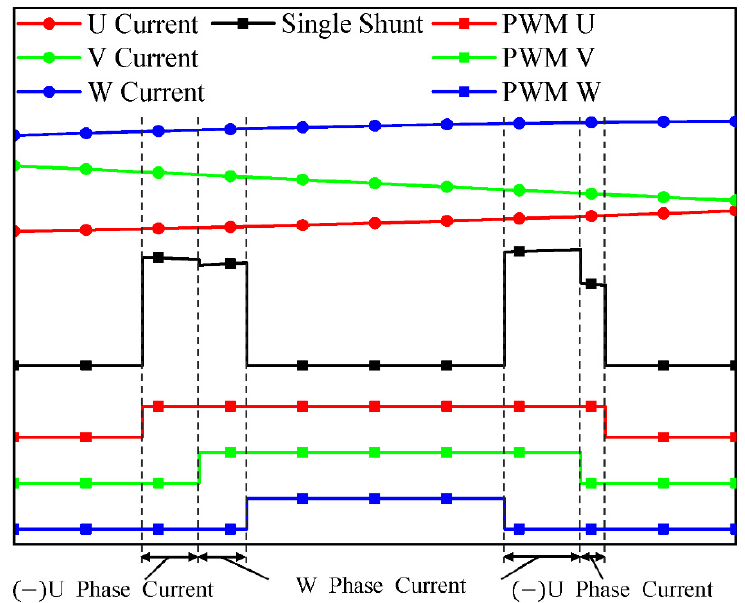
Figure 2. Current detection and PWM waveform in single-shunt resistor inverter.